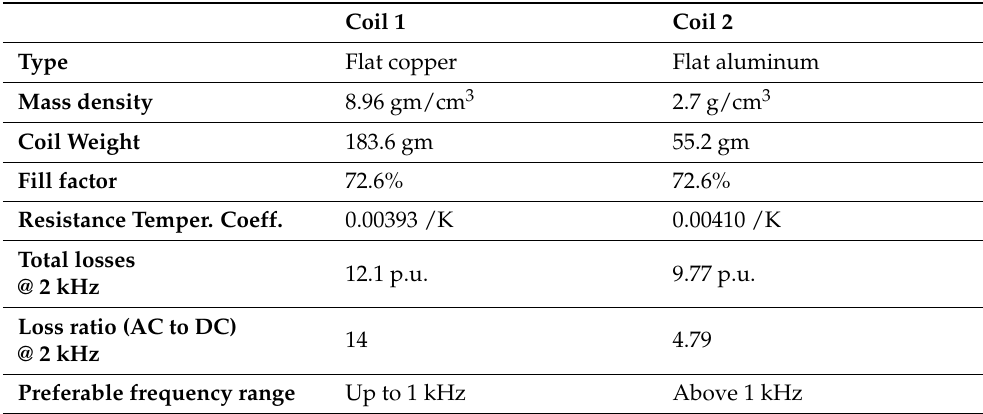
Table 1. Comparison between the copper and aluminum flat